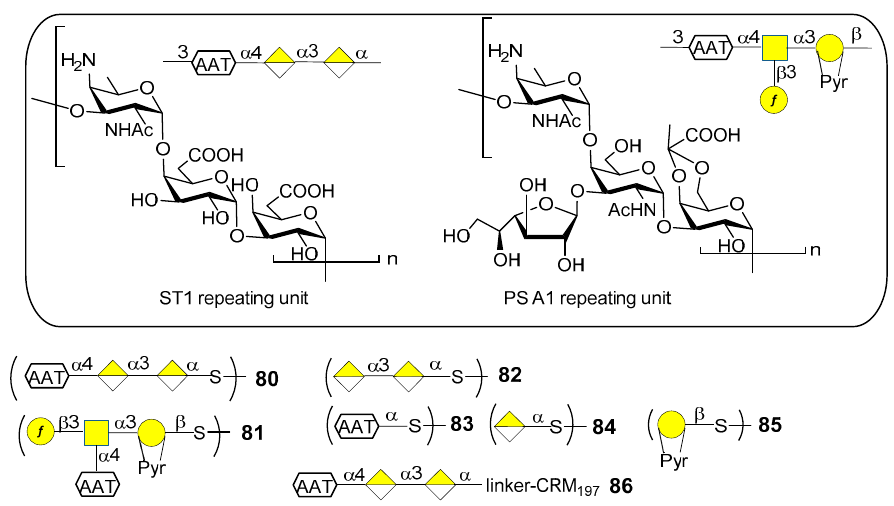
Figure 10. Repeating units of Streptococcus pneumoniae 1 CPS and Bacteroides fragilils PS A1 CPS and synthetic glycan fragments reported in [72].